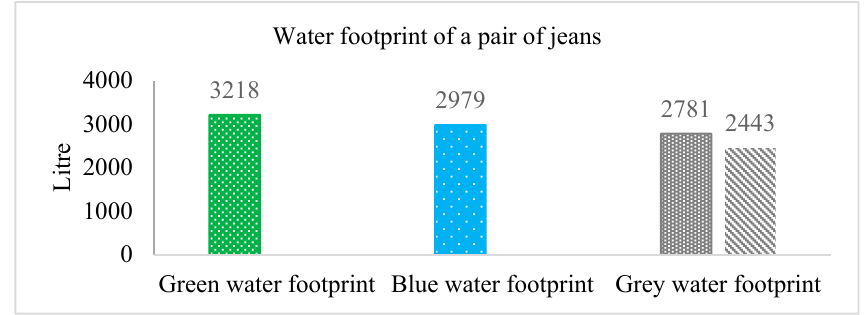
Figure 15. Water footprint of a pair of jeans; with and without having functional ETP and STP, the grey water footprint would be 2443 L and 2781 L, respectively.